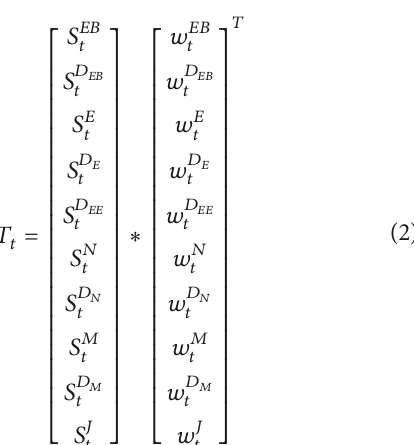
due to the interaction among the considered features and because the facial features included in the models do not cover the whole